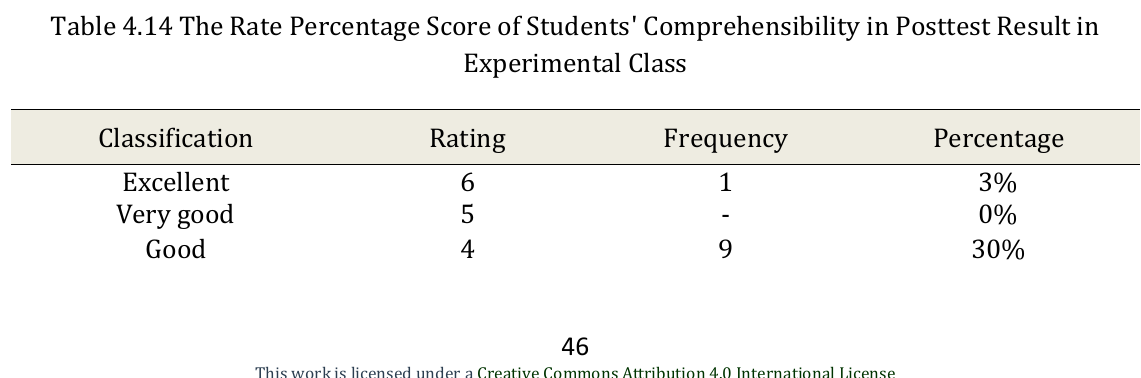
Table 4.14 The Rate Percentage Score of Students' Comprehensibility in Posttest Result